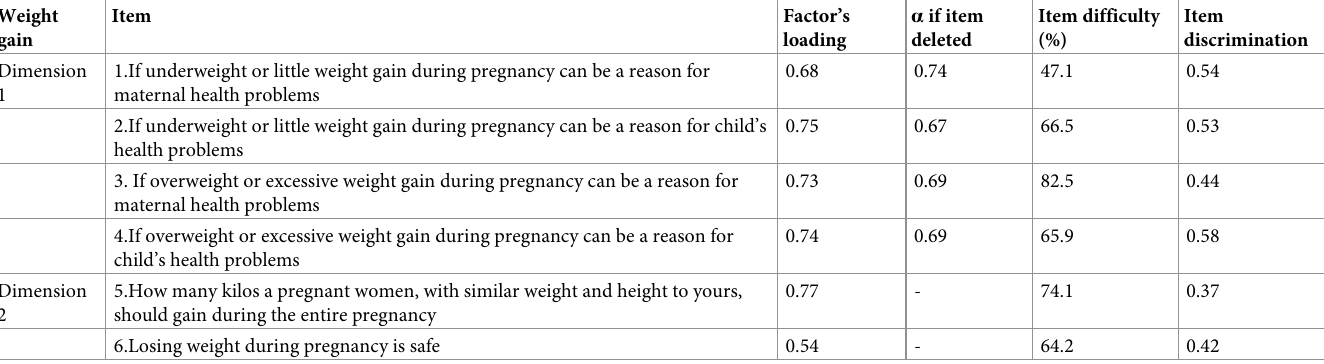
Table 4. Weight gain domain: Factor analysis and reliability analysis